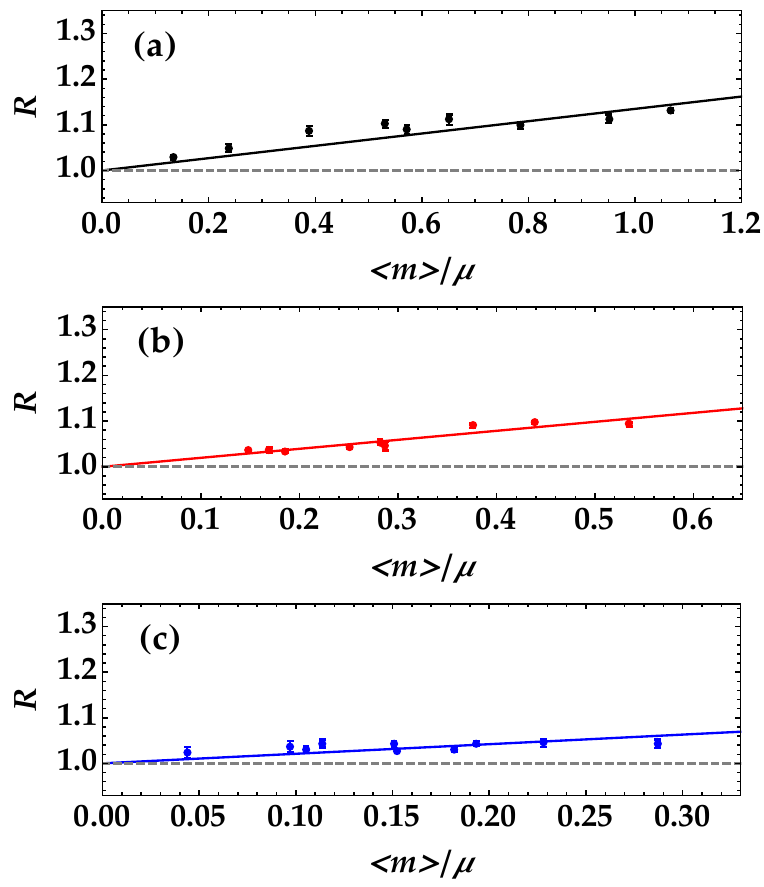
Figure 4. R as a function of the mean number of photons per mode for three different values of µ . The data are shown as colored dots + error bars, while the theoretical curves according to Equation (6) are shown as colored lines. From the fitting procedure, we obtain the value of t . In particular, in Panel ( a ), t = 0.54 ± 0.02 (case µ = 1.03 ± 0.01), in Panel ( b ), t = 0.46 ± 0.01 (case µ = 2.8 ± 0.1), and in Panel ( c ), t = 0.45 ± 0.03 (case µ = 6.2 ±